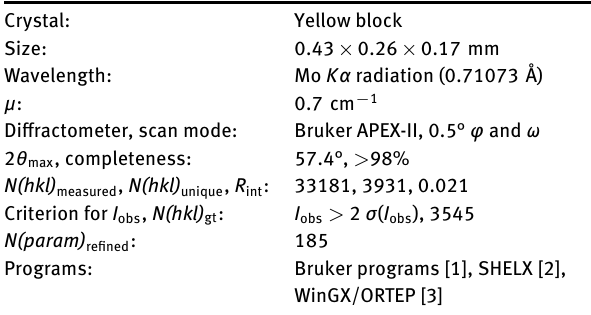
Table 2: Fractional atomic coordinates and isotropic or equivalent isotropic displacement parameters (Å 2